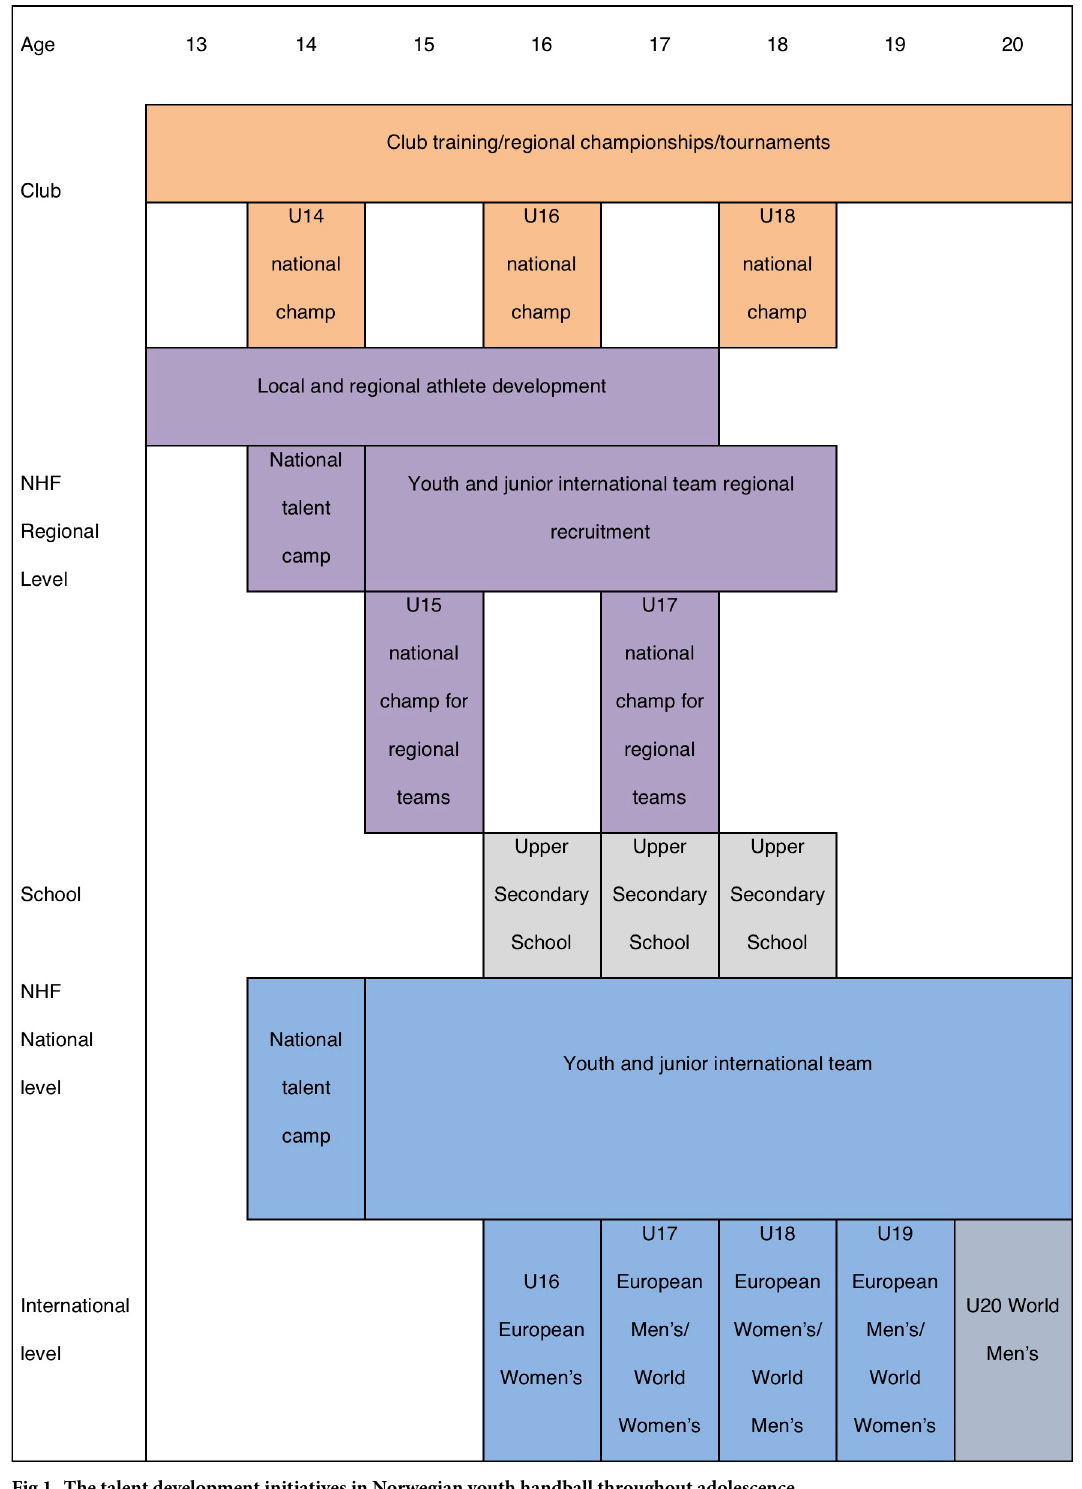
Fig 1. The talent development initiatives in Norwegian youth handball throughout adolescence.